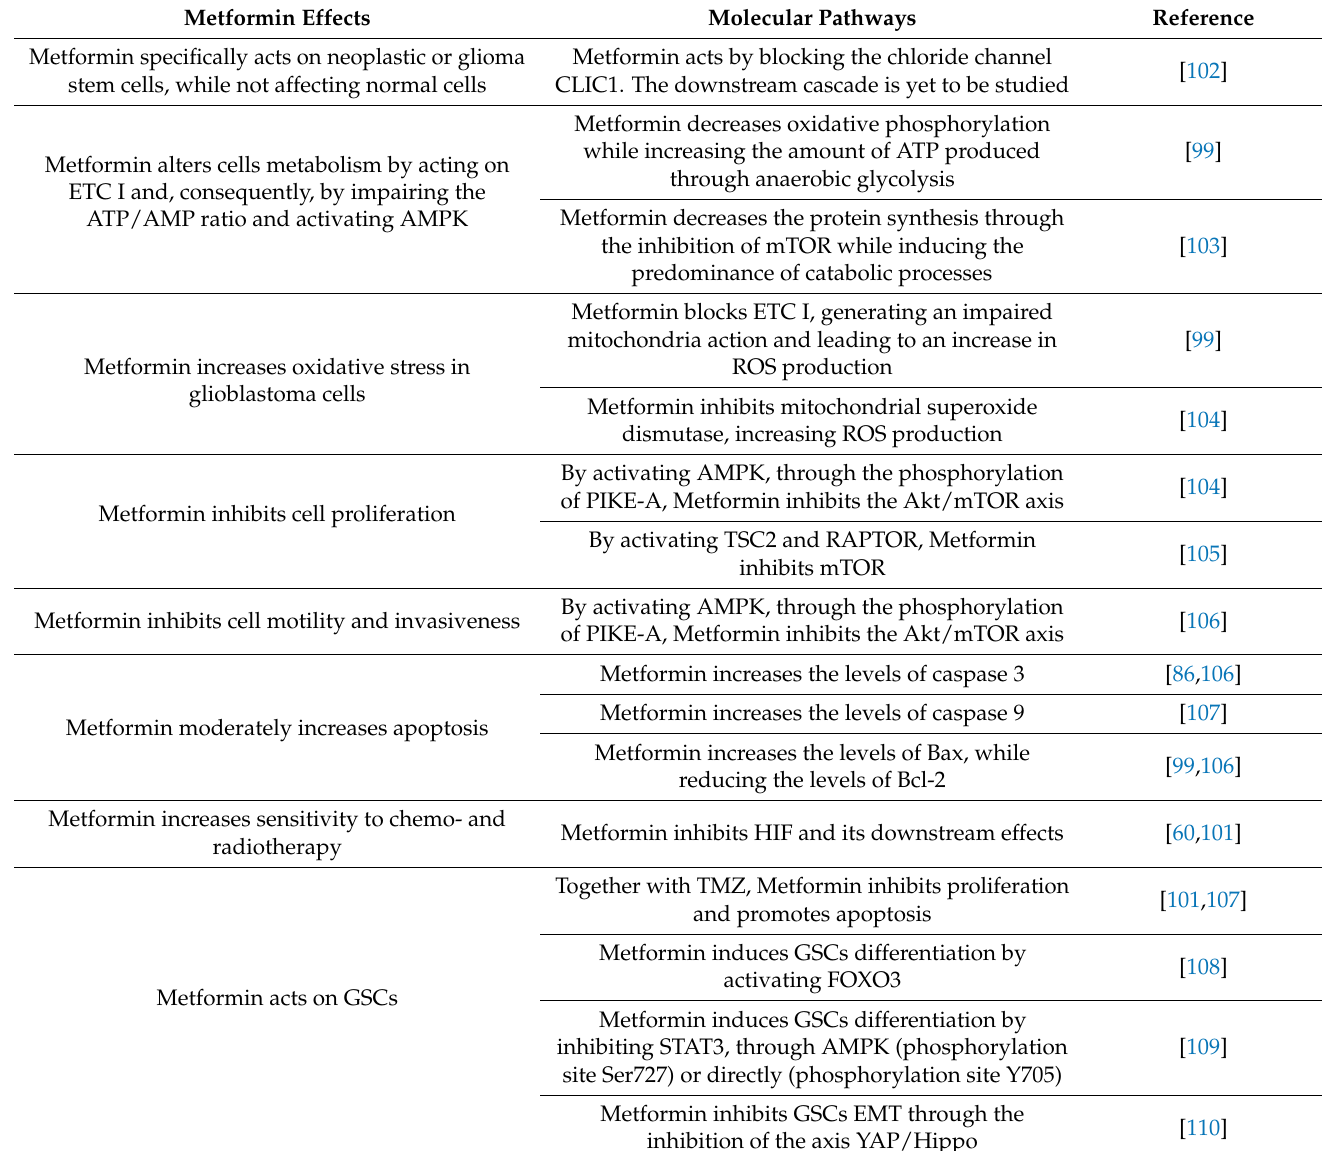
Table 2. Overview of in vitro and in vivo studies reporting an anti-glioblastoma effect of